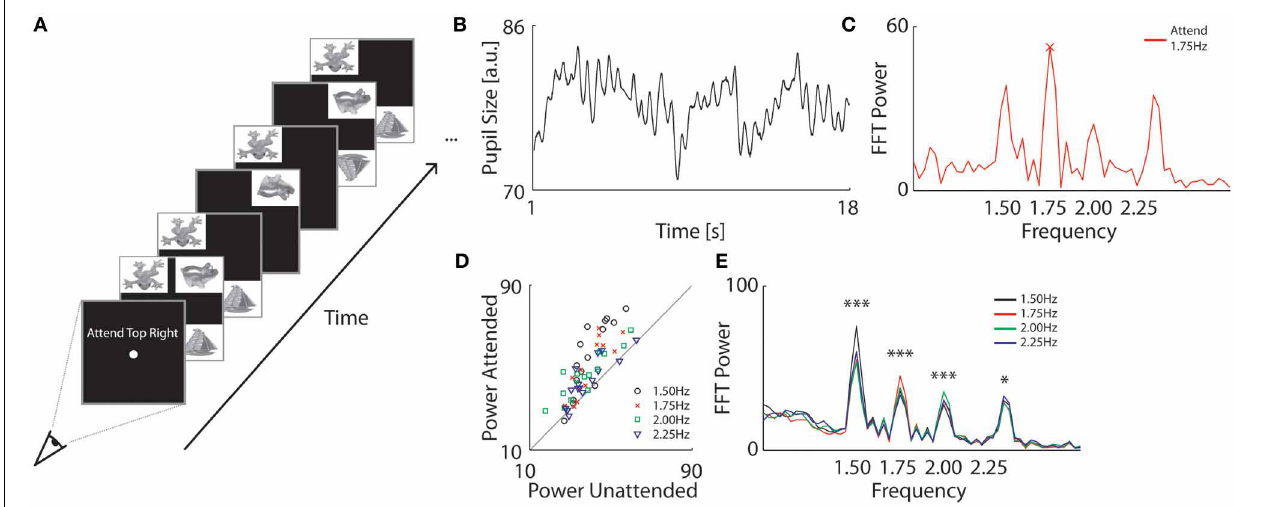
FIGURE 2 | Pupillary assessment of spatial focal attention. (A) Procedure of Experiment 2. Observers fixated at the screen center and counted the number of times the attended object flipped upside down. Each quadrant had an object within a white rectangle that flickered off-and-on at a separate frequency (1.5, 1.75, 2.0, and 2.25Hz). (B) Example of an observer’s pupil size during a single trial ( black ). The four flickering stimuli induced continuous pupil oscillations. (C) Example of a single trial FFT power spectrum analysis of the pupil trace in (B) . The four peaks at the presented frequency indicate that each quadrant left an oscillatory trace in the pupil. In this trial, the observer specifically attended